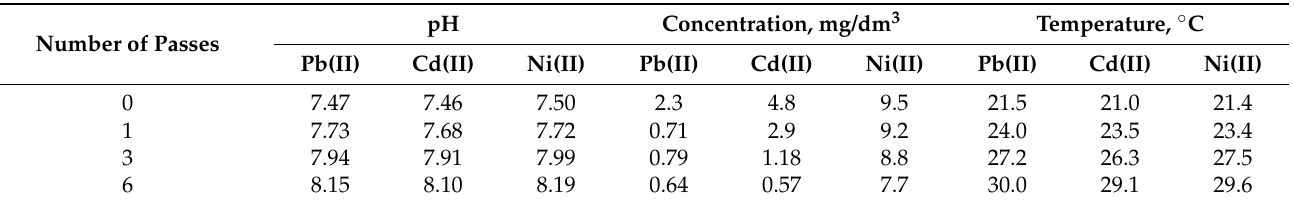
Table 8. The pH of the solution, metal concentration and solution temperature for the tested solutions.